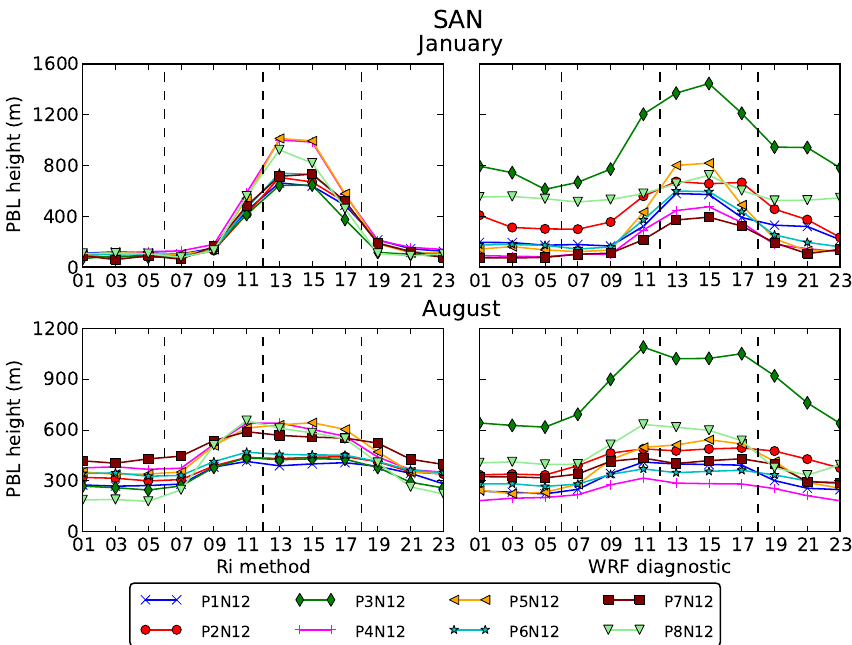
Fig. 2. Diurnal cycle of the simulated PBL heights for the eight PBL schemes at San Diego airport for January and August 2009 (local time) using medians. On the left, the heights as calculated using the Richardson bulk number. On the right, the heights as diagnosed by WRF.